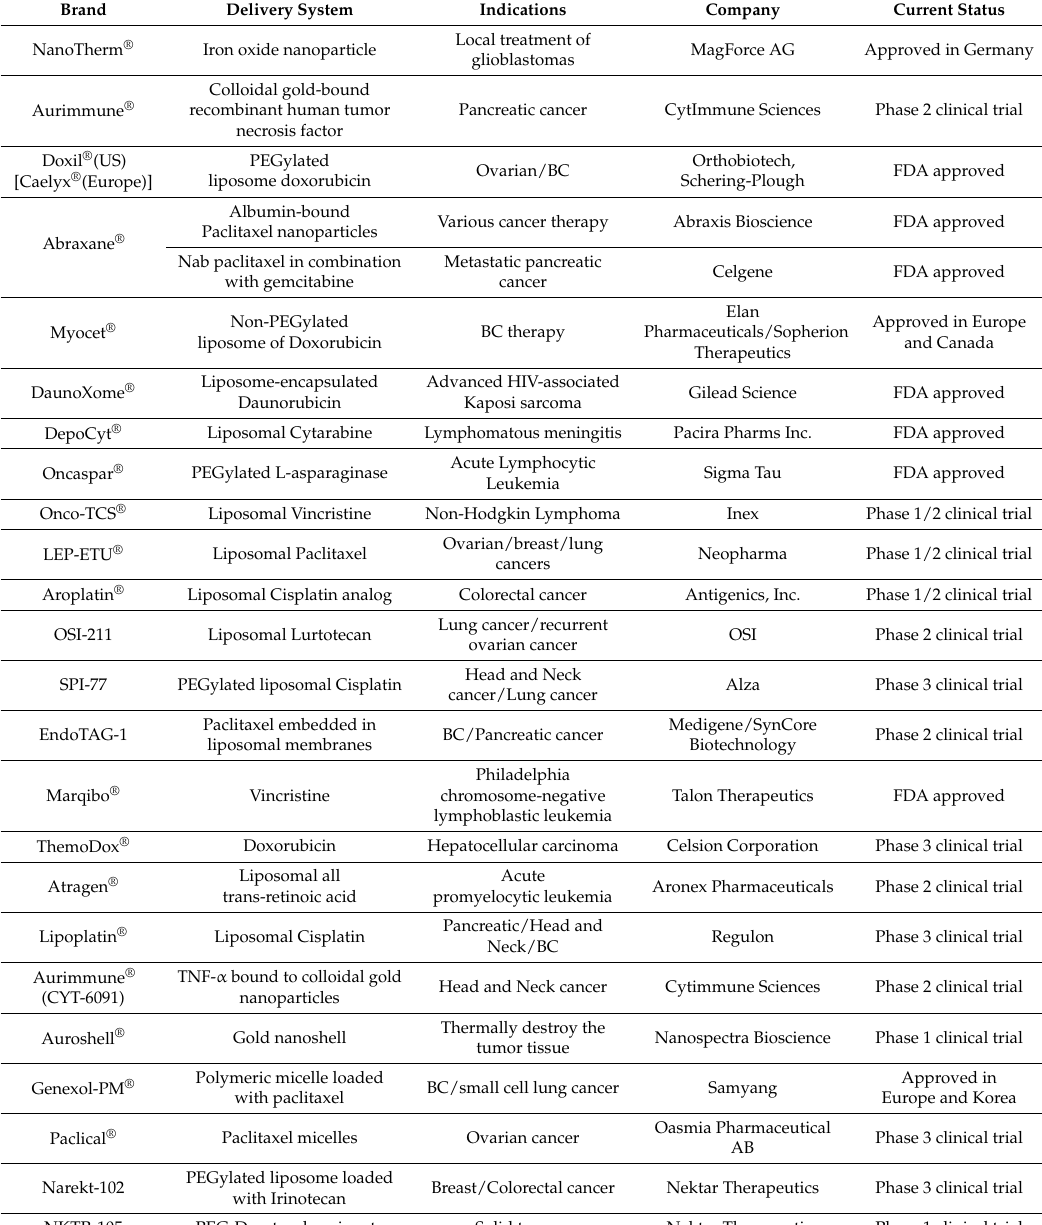
Table 2. Cancer-treating nanomedicines already approved or being applied in the clinical